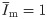
Contour plots of the cost function for paclitaxel (left column) and sirolimus (right column) over the design space consisting of initial concentration in the stent polymer
c
0 and release time
t
E.The scale for the cost function representation is truncated at a maximum of 1; all values larger than 1 are colored black. The dashed magenta lines in panels A and B mark the time scales for drug unbinding. The green contour line traces I¯m=1, the yellow contour line T¯m=1, and the red contour line T¯e=1. The horizontal axis at the top of the plot marks the time points of 1 (h)our, 1 (d)ay, 1 (w)eek, 1 (m)onth and 1 (y)ear. Gray dots indicate evaluated designs. Optimization cases A: paclitaxel release and B: sirolimus release with baseline cocnentration thresholds. C: Paclitaxel release and D: sirolimus release with concentration thresholds reduced by a factor of 10. E: Paclitaxel release and F: sirolimus release with concentration thresholds increased by a factor of 10.